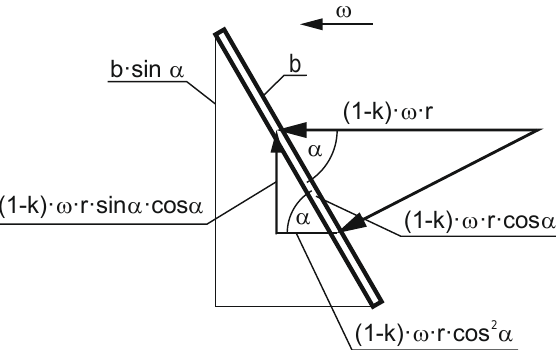
Figure 1. Distribution of velocity vectors for an inclined blade.